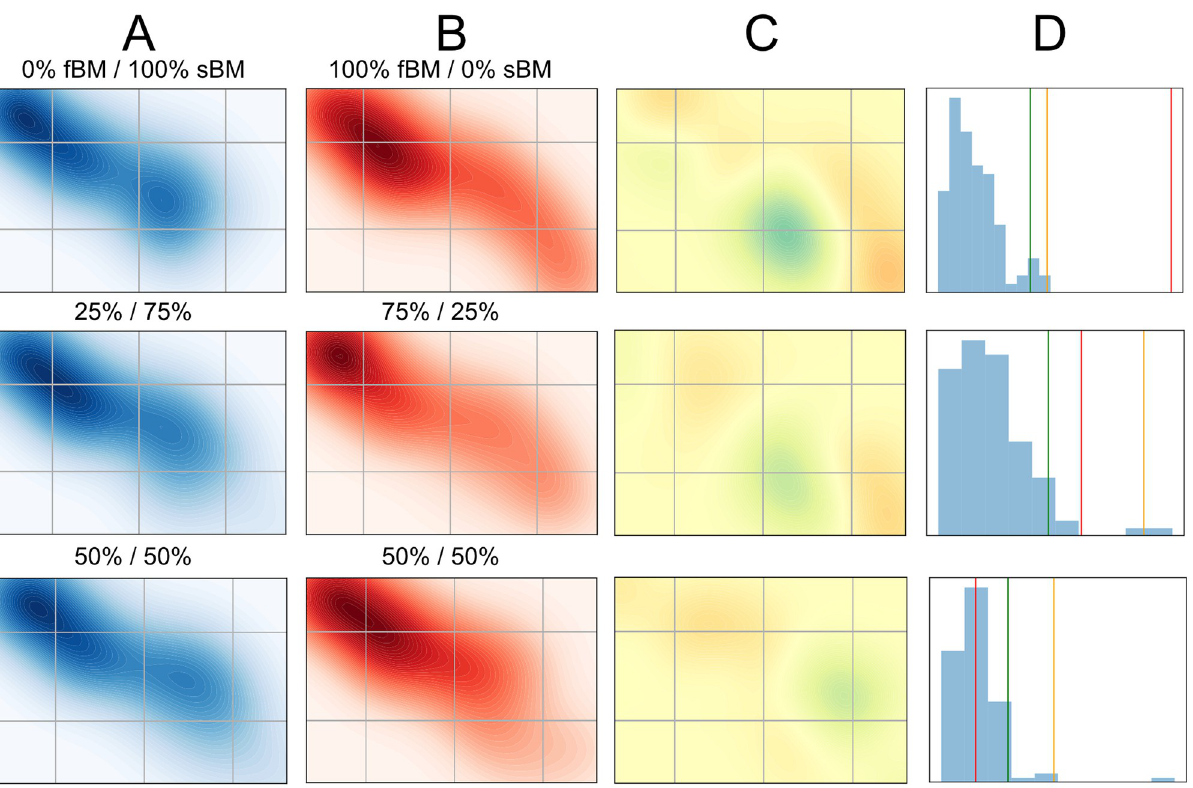
Fig 4. MMD-based statistical test. ( A ), ( B ) Densities of latent vectors in the 2D plane, for two sets of 500 trajectories with different ratios of fBM / sBM trajectories (top: 0% fBM / 100% sBM vs. 100% fBM / 0% sBM, middle: 25% / 75% vs. 75% / 25%, bottom: 50% / 50%). ( C ) Witness functions of the MMD test for difference between A and B, i.e. the function attaining the maximum in Eq 1, based on the available samples. ( D ) Distribution of the test statistic MMD 2 between sets of equal size composed of randomly chosen trajectories of the two sets, with its top 1% (yellow line) and top 5% percentiles u (green), as well as the unbiased estimate of the square MMD between the two sets (red).